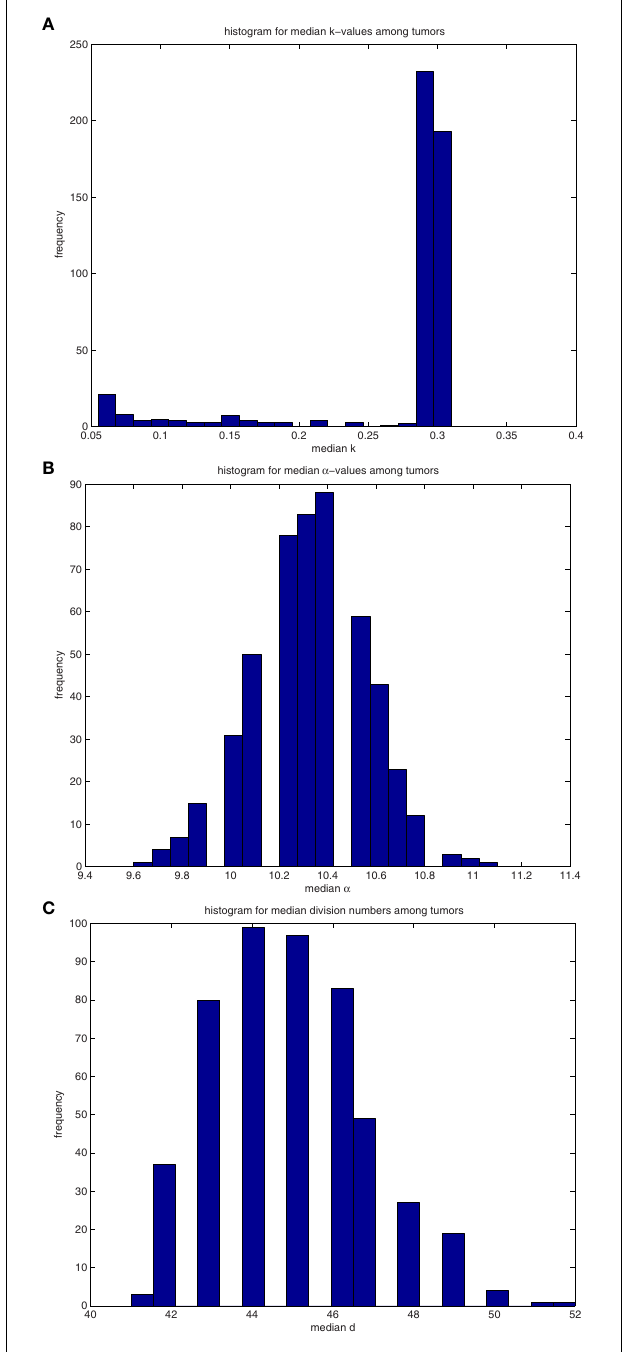
FIGUREA3 | (A) Histograms for the median values of differentiation coefficient k from 500 tumors spawned fromTICCs. (B) Histograms for the median values of proliferation potential α from 500 tumors spawned from TICCs. (C) Histograms for the median values of division number d from 500 tumors spawned fromTICCs.